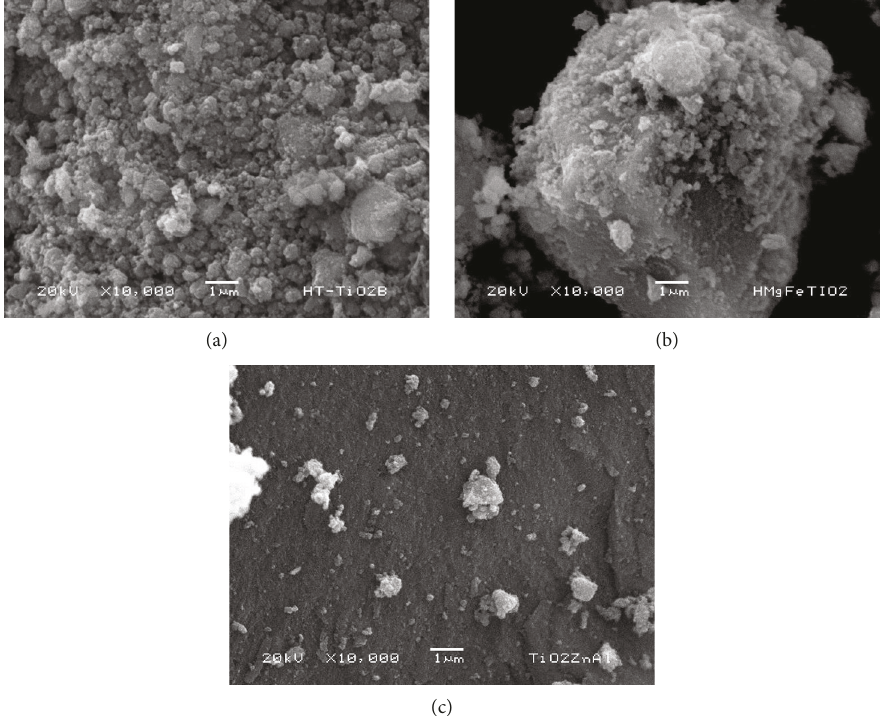
Figure 3: Micrographs for the TiO